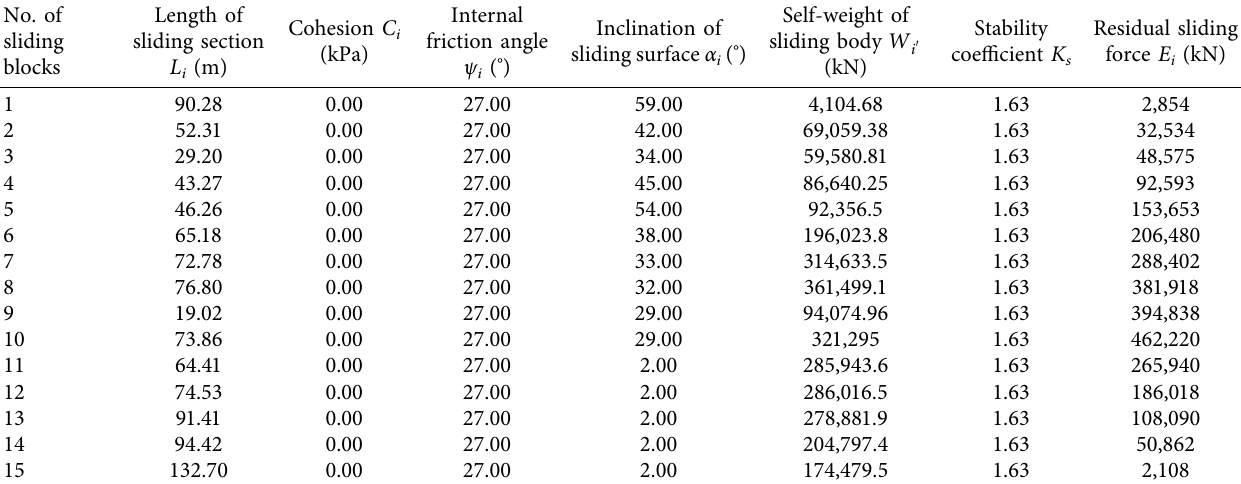
Table 9: Stability calculation for southern slope (case 2a: fracturing surface of 6# coal seam).